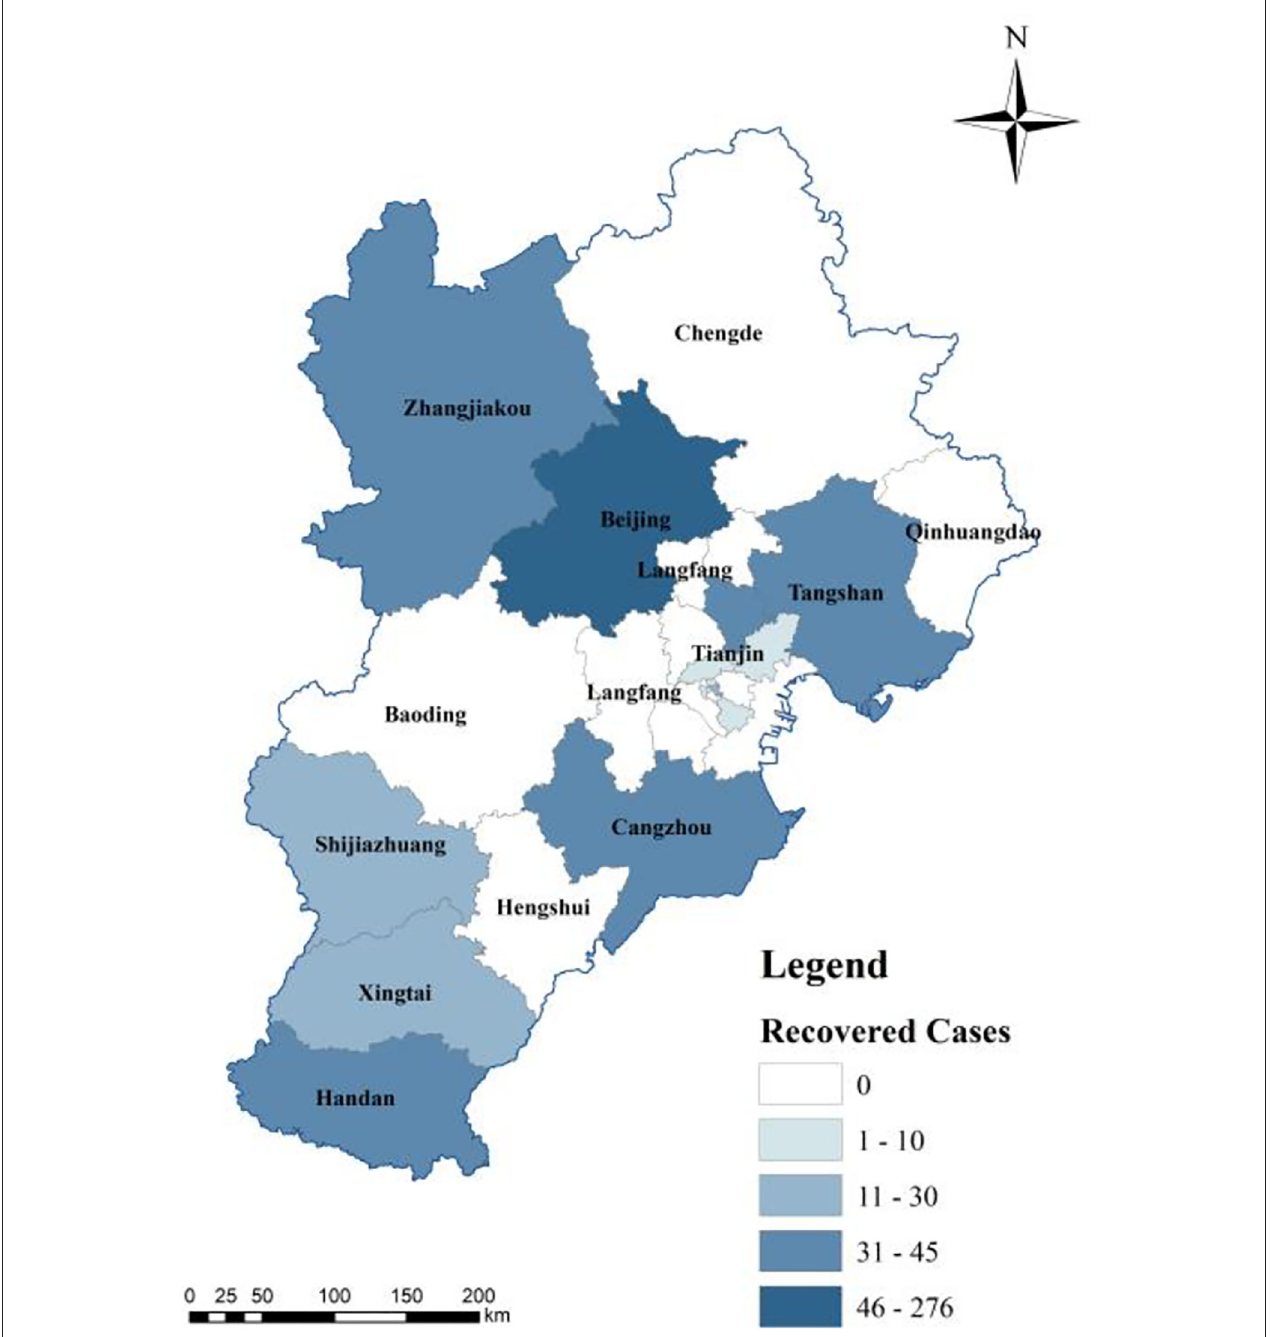
FIGURE 7 | Spatial distribution of discharged